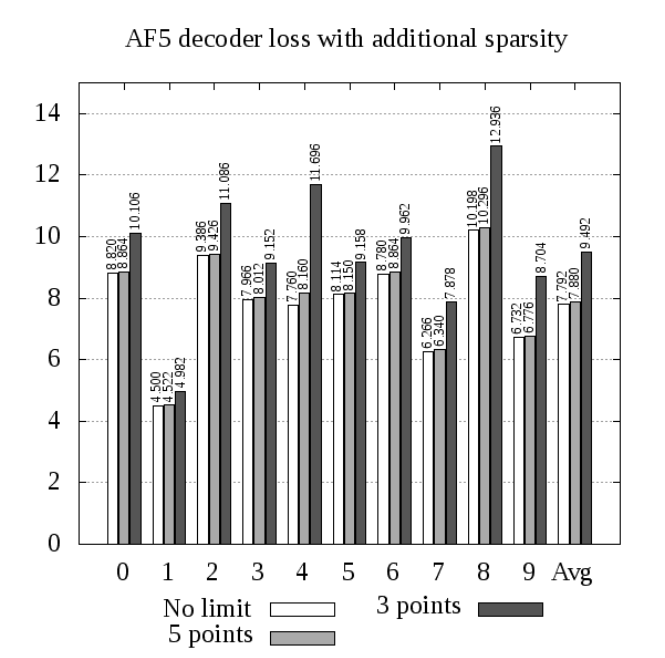
Figure 6. The pretrained decoder from AF5 used for decoding of both the original and the highly sparse data, as in Figure